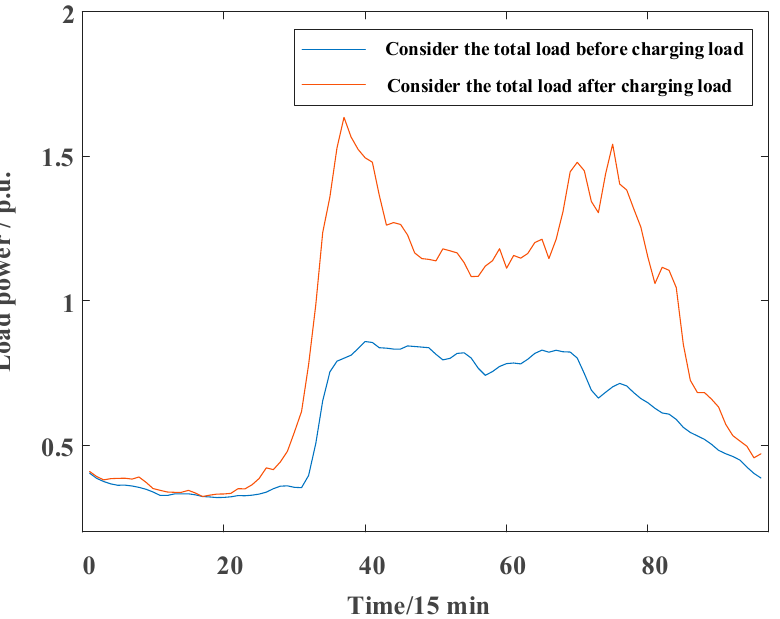
Figure 13. Total load curve before and after considering EV access.